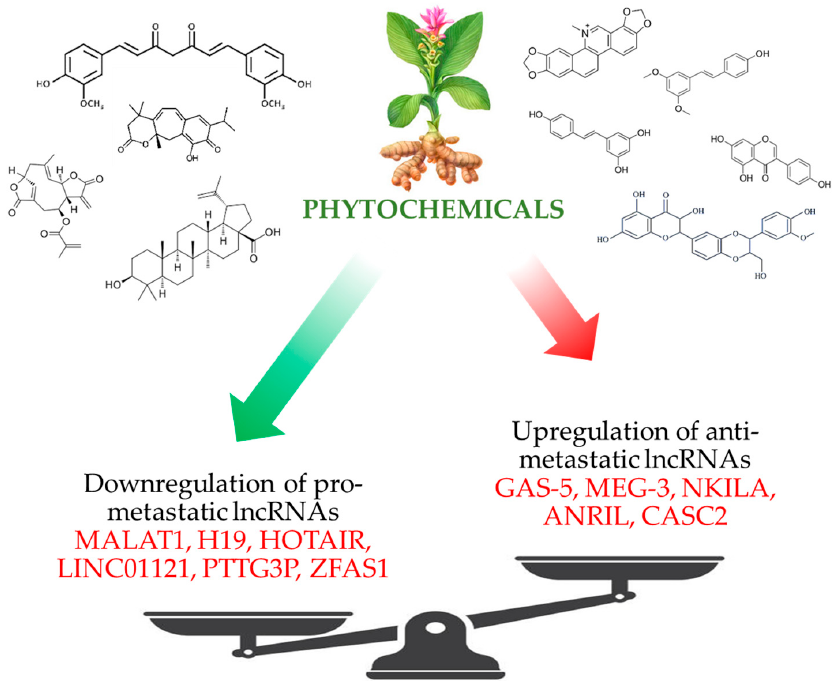
Figure 4. Schematic representation of the effects of phytochemicals on the balance between the expressions of pro- and anti-metastatic LncRNAs.